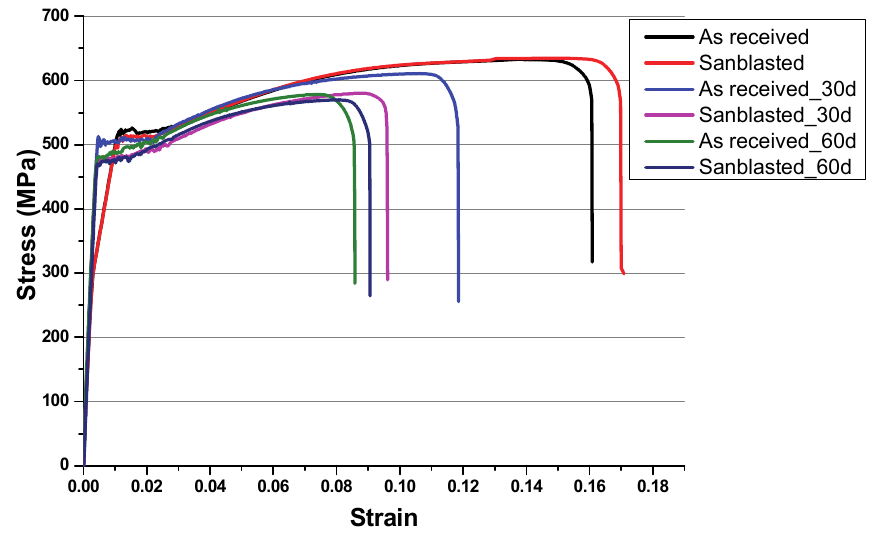
Figure 11: Tensile load-displacement curves of as-received as well as sandblasted specimen at each corrosion exposure period.